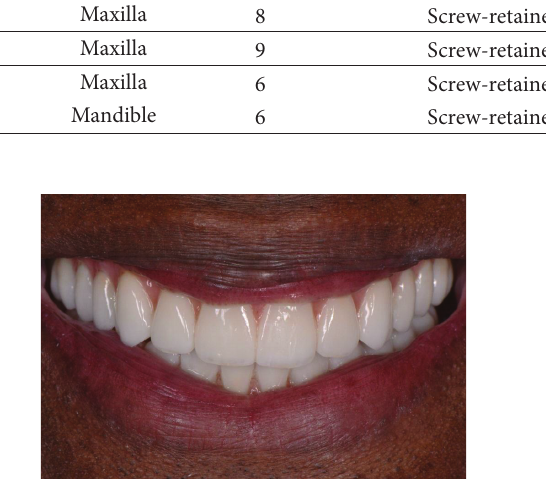
Figure 12: Smile view of the final